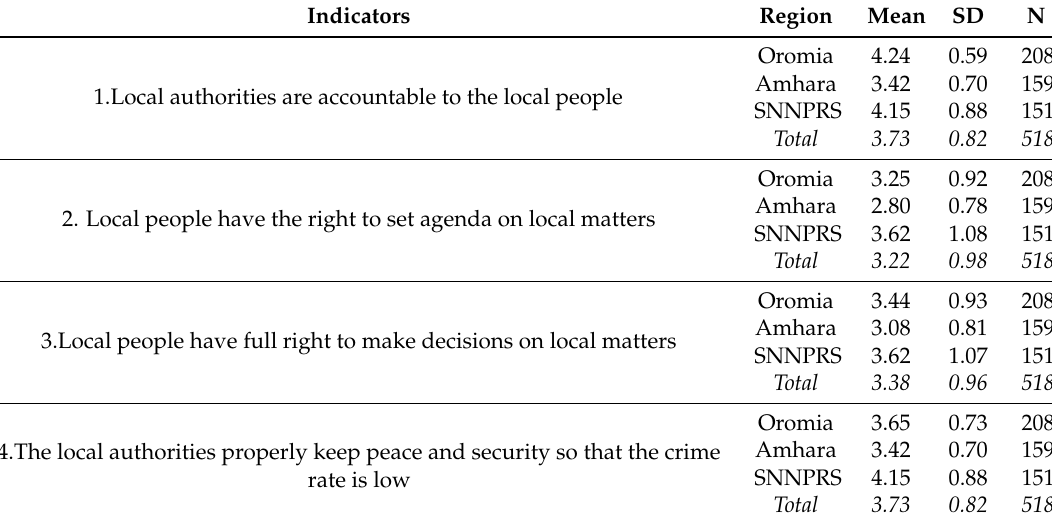
Table 4. Mean scores and standard deviations (SDs) of indicators of power-relations (N = 518). Indicators Region